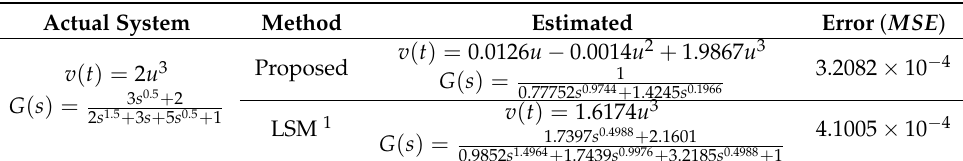
Table 2. Identification results for Example 2.